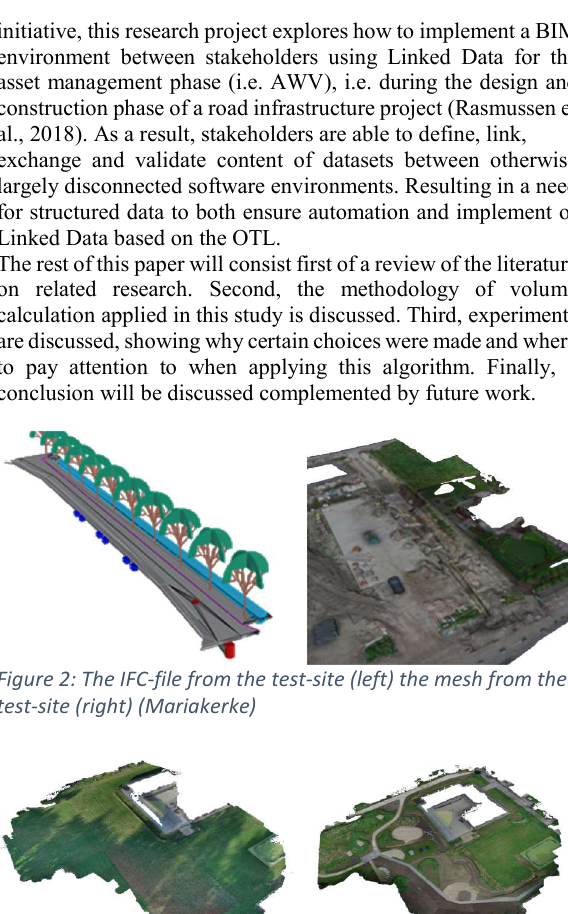
Figure 1: Problem of occlusions on construction sites. (a) Stock material and excavator seen from a georeference image. (b) The corresponding gaps in the point cloud. (c) The filled gaps in the mesh.